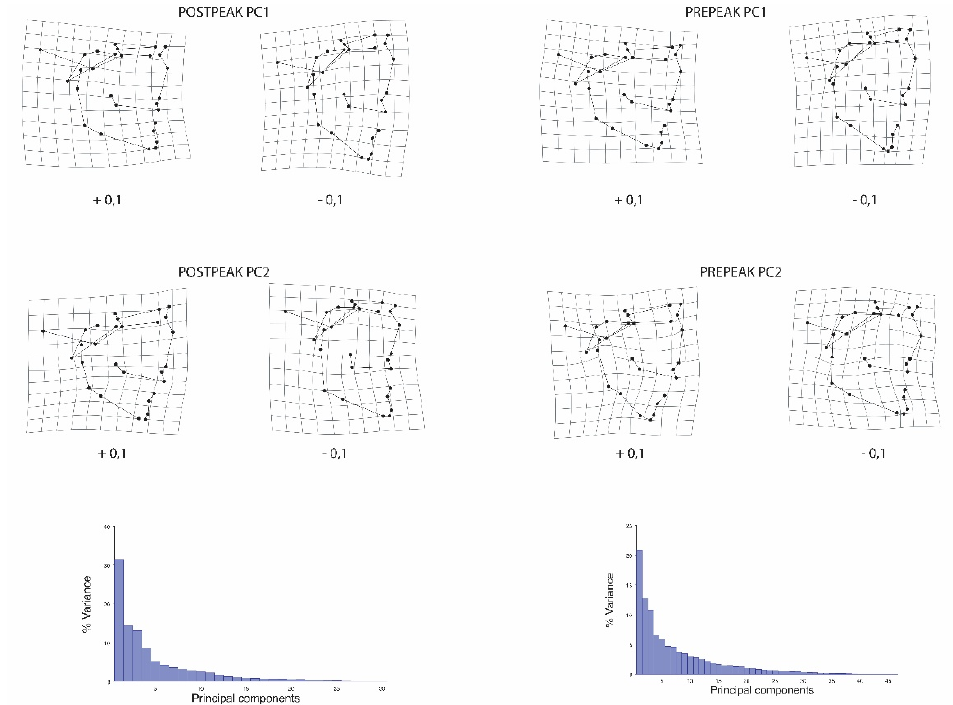
Figure 1. Variation in the position of the landmarks, coinciding with a variation of 0.1 of the main components 1 and 2 obtained by a PCA on the whole set of landmarks and the variance explained by the components themselves.